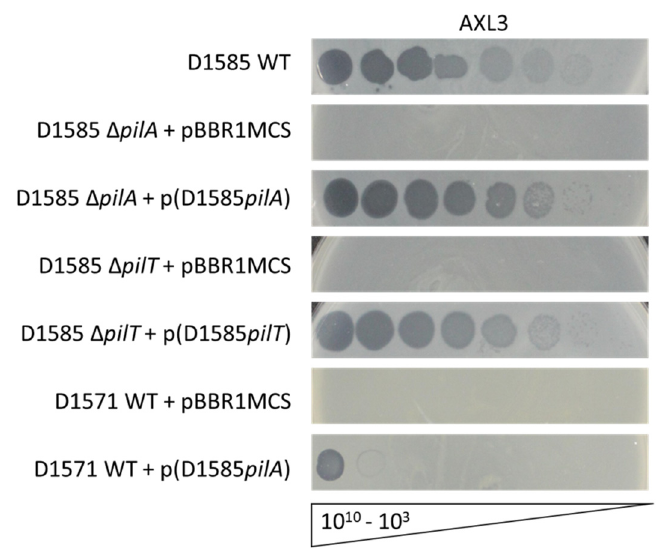
Figure 2. S. maltophilia bacteriophage AXL3 requires a functional type IV pili for infection. Wildtype (WT) S. maltophilia strain D1585 is susceptible to AXL3. Deletion of the major pilin subunit encoded by pilA , or the retraction ATPase encoded by pilT , abolishes infection by AXL3. Complementation restores phage infection to wildtype levels. Exogenous expression of the D1585 pilA gene in a phage-resistant host, D1571, permits AXL3 infection. Images are representative of three biological replicates, each with three technical replicates.